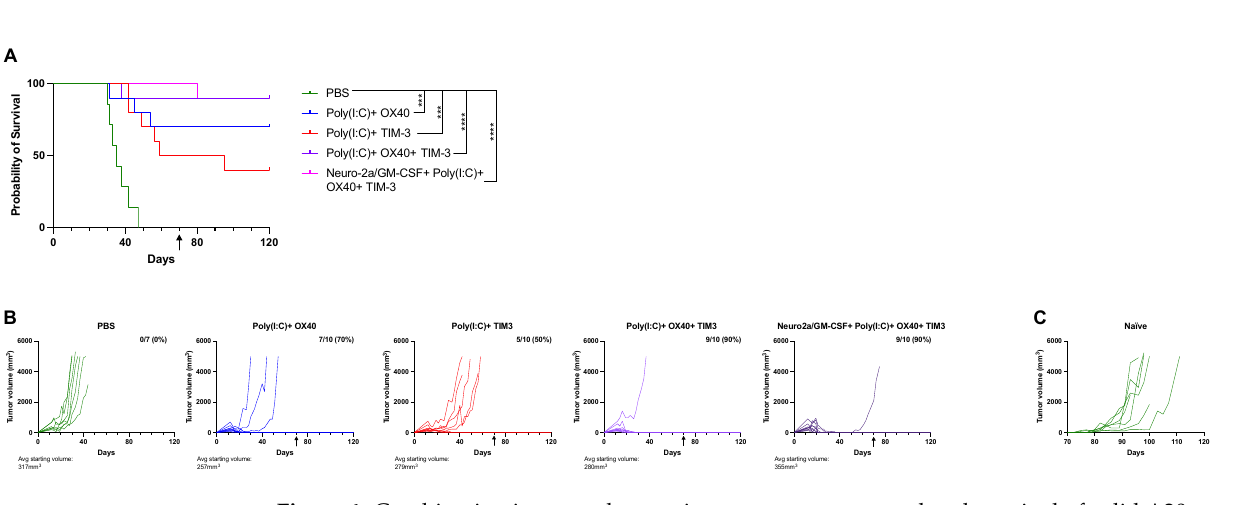
Figure 4. Combination immunotherapy improves tumor control and survival of solid A20 tumor-bearing mice and generates tumor-specific immunological memory. A20 tumor-bearing mice were randomized into treatment groups and mice received 3 intratumoral injections of indicated treatments. ( A ) Kaplan-Meier survival graph of mice in each treatment group. Statistical differences were assessed using the Log rank test with the level of significance denoted by the number of asterisks: *** p < 0.001, **** p < 0.0001. ( B ) Individual mouse tumor growth illustrated by treatment group. Tumors were sized 2–3 times per week and tumor size was calculated as described in Section 2. Mice were removed from the study once tumors reached a size of >5000 mm 3 . ( A , B ) Tumor-free mice were challenged for a second time with A20 tumor on the opposing flank at day 70, indicated by the black arrow on graphs. ( C ) Tumor growth of individual naïve control mice challenged with A20 lymphoma.